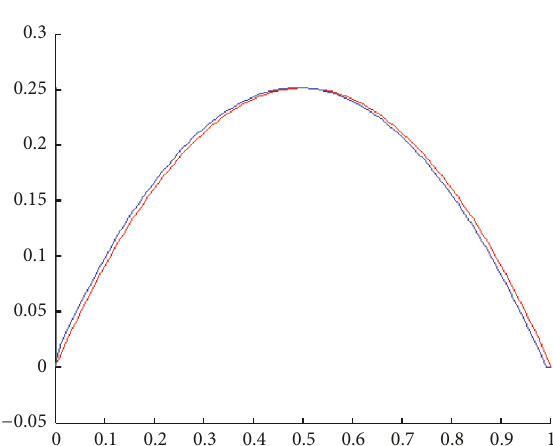
Figure 9: Initial temperature. This figure shows that we can rebuild the initial state.